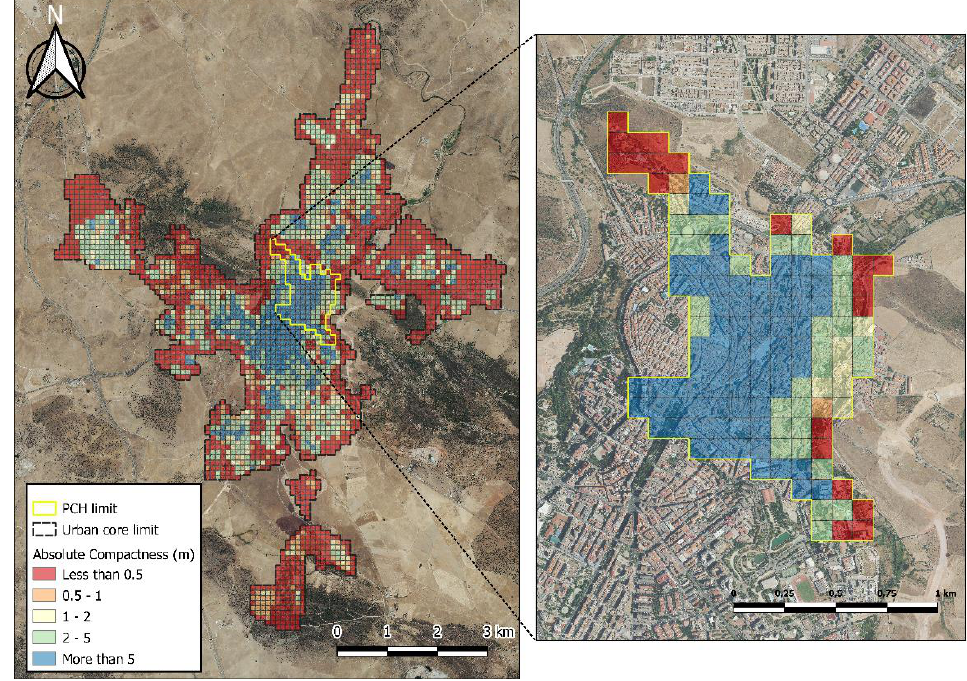
Figure 4. Absolute compactness comparison.